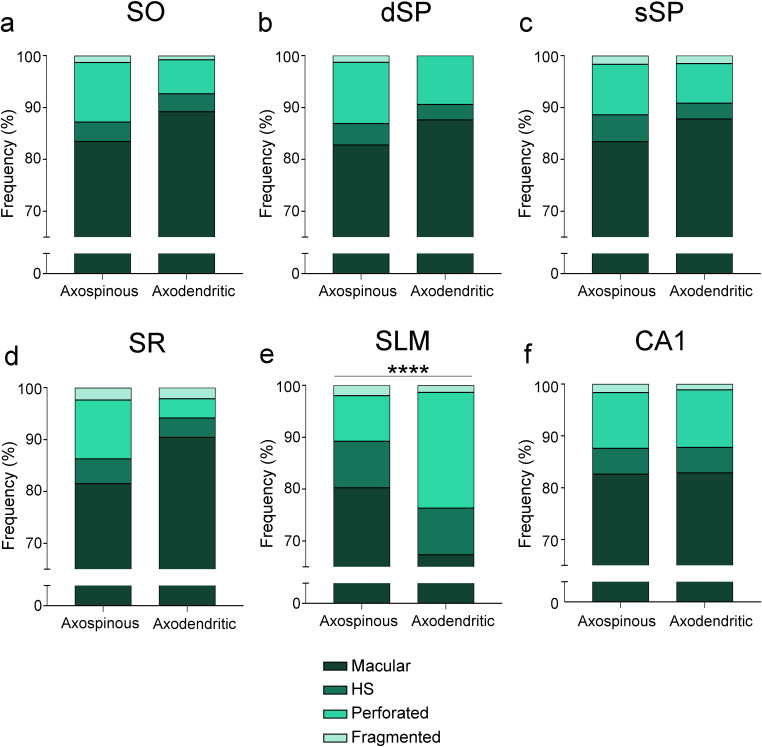
Frequency plots for every type of synaptic shape found among axospinous AS and axodendritic AS.(a−f) Plots are shown for all layers (a−e) and for the CA1 region as a whole (f). Only in SLM, non-macular synapses are more abundant in the axodendritic AS population than in the axospinous AS one. Moreover, overall, SLM presents a higher frequency of complex-shaped synapses than other layers (see Figure 2). AS: asymmetric synapses; SO: stratum oriens; dSP: deep stratum pyramidale; sSP: superficial stratum pyramidale; SR: stratum radiatum; SLM: stratum lacunosum-moleculare. ****p<0.0001.